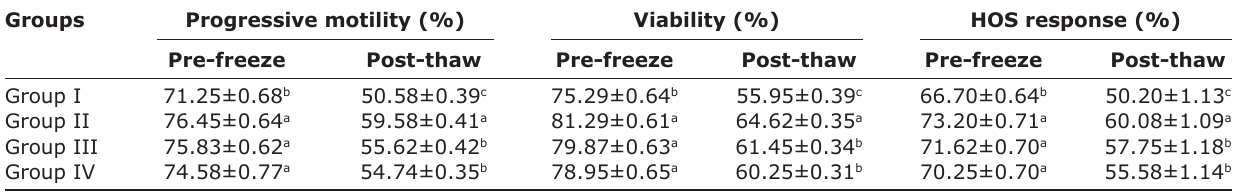
Table-2: Mean±SE of effect of incubation on progressive motility, viability and HOS response at pre-freeze and post-thaw stage of buffalo spermatozoa.